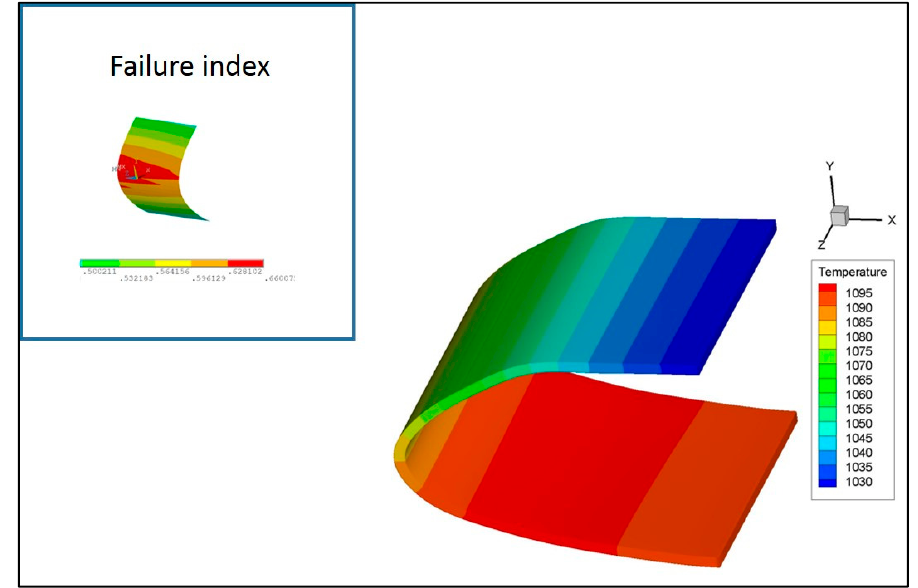
Figure 12. Temperature contour plot at 1200 second – Local model B – BC taken from the global coarse solid model – Temperatures are expressed in °C.